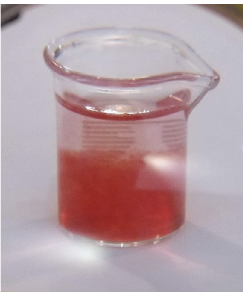
Figure 5. Formation of a red colored Al(III)-aluminon